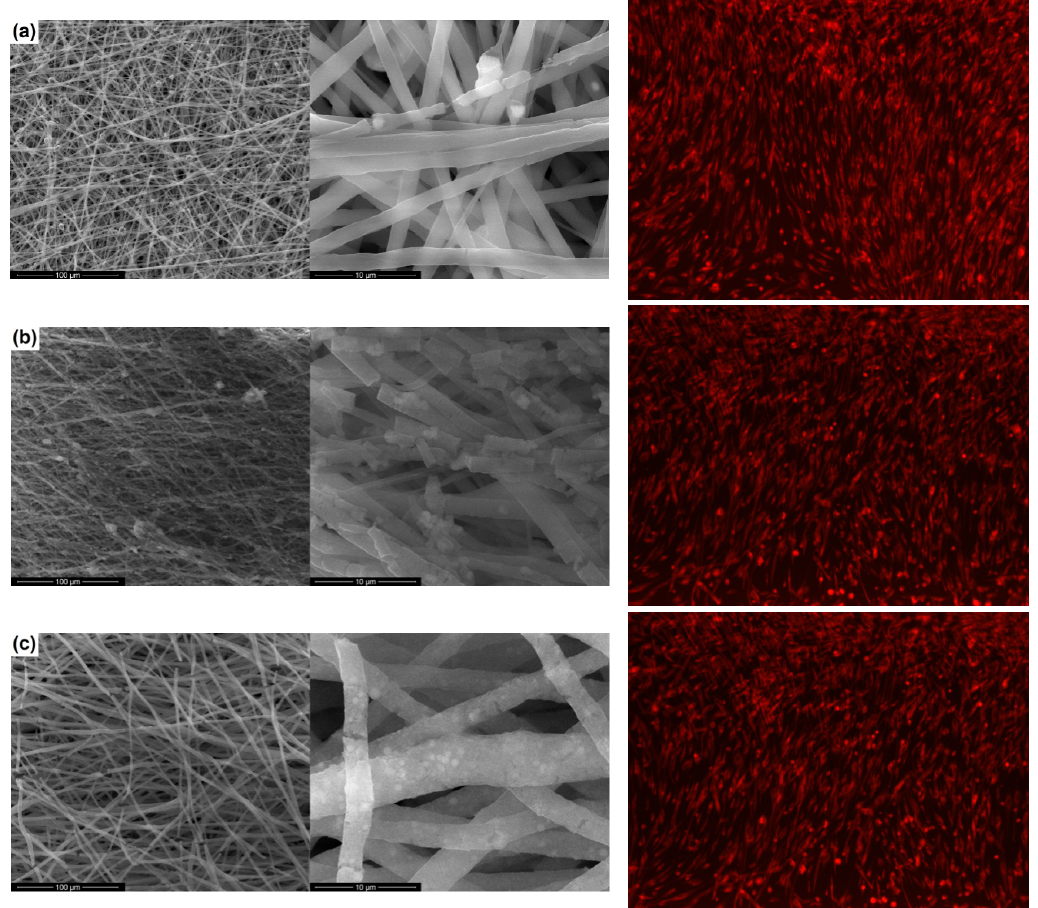
Figure 4. SEM images after SBF immersion for 14 days (left) and fluorescence microscopy images (right) of mesenchymal stem cells in contact with the composite scaffolds: ( a ) PCL-ZnO, ( b ) PCL-TiO 2 , and ( c ) PCL-HAp.